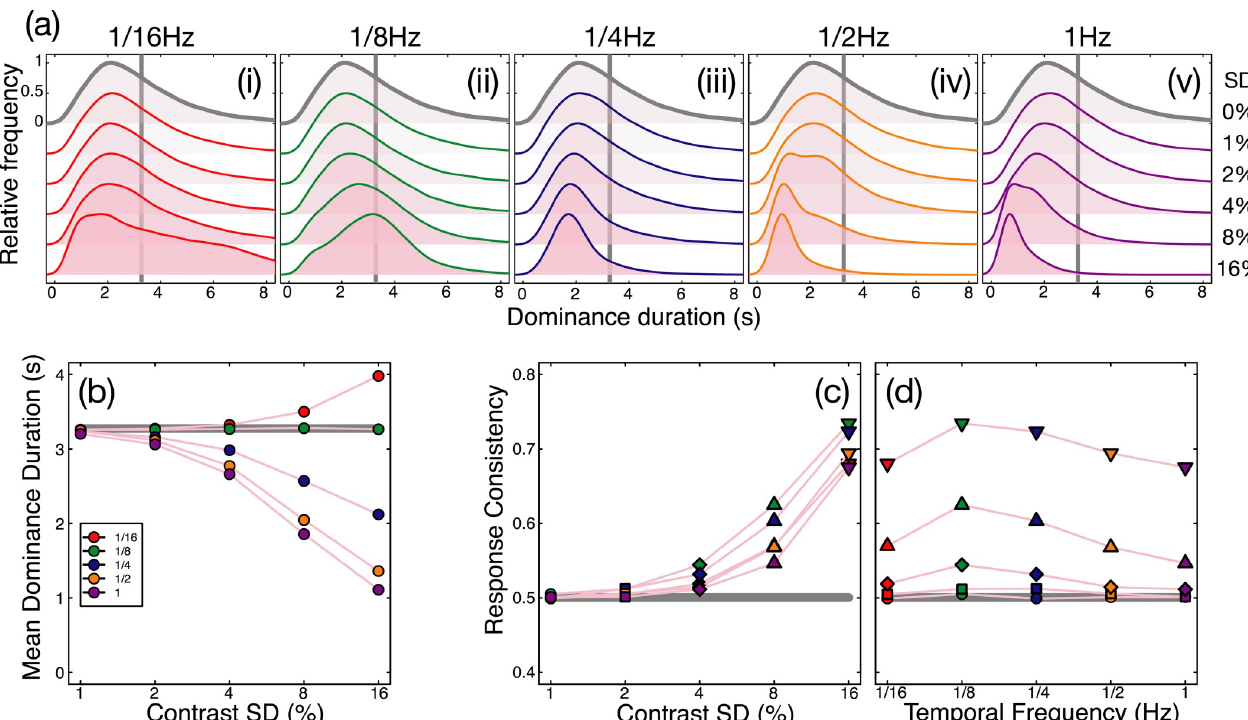
Fig 6. Summary of modelling results. (a) Histograms of dominance durations of the model with pink ( α = 1) internal noise of with a standard deviation of 16% for each stimulus temporal frequency (i-v) and contrast SD. The solid line colour serves as a legend for the stimulus noise temporal frequency (red = 1/ 16Hz, green = 1/8Hz, blue = 1/4Hz, yellow = 1/2Hz, purple = 1Hz). The histogram marked in grey represents baseline dominance durations with no contrast modulation. (b) The mean dominance durations of the histograms in (a). Marker colour represents the modulation temporal frequency, while the x-axis gives the modulation contrast. The grey line marks the baseline dominance duration of the model (3.18s), slightly slower than that of the human data. (c-d) Model response consistency plotted in the same manner as Fig 4. In (c), marker colour indicates the modulation temporal frequency while the x-axis indicates the modulation contrast. For all stimulus frequencies, response consistency increased according to modulation contrast, and was greatest when the stimulus temporal frequency was 1/8Hz. (d) Identical data but plotted with modulation temporal frequency on the x-axis. The grey line (c,d) marks response consistency at baseline with no external noise fed to the model